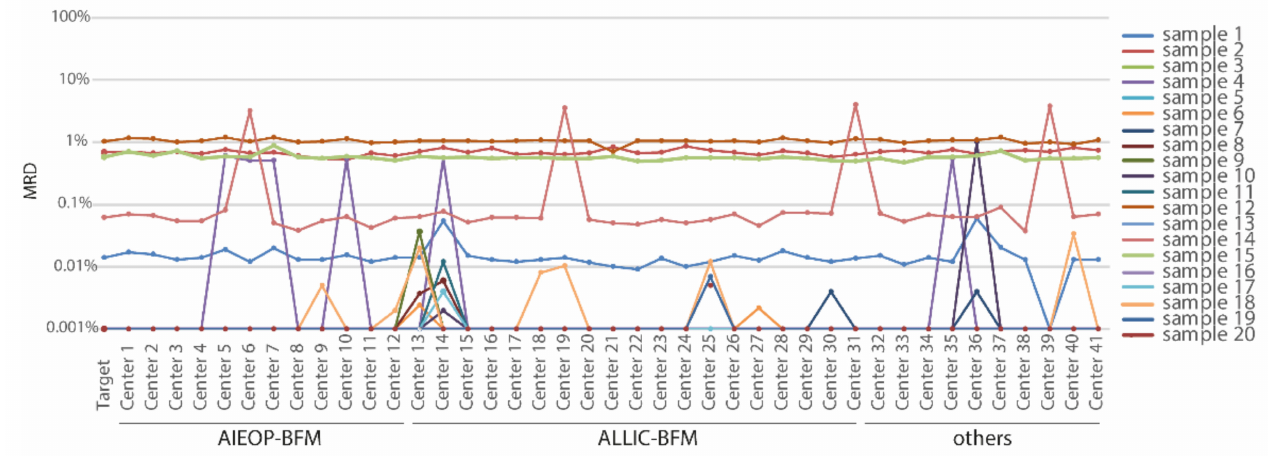
Figure 4. Plot from a representative list-mode file ring trial. RT 2020 comprised 20 regenerative bone marrow samples with either negative or varying levels of MRD. LMD files were sent out to 41 centers, all of which reported results. AIEOP- BFM n = 12, ALL IC-BFM = 19, and other I-BFM cooperating centers = 10. The target MRD value was calculated as a median from six experienced and matured AIEOP-BFM reference laboratories (Vienna, Monza, Padova, Prague, Kiel and Berlin). Two opportunities for educational intervention can be seen in this figure: (i) similar errors by four and six centers, respectively, in samples 14 and sample 4 representing a systematic error; and (ii) an accumulation of errors in single centers (see center 13 and 14) representing lack of